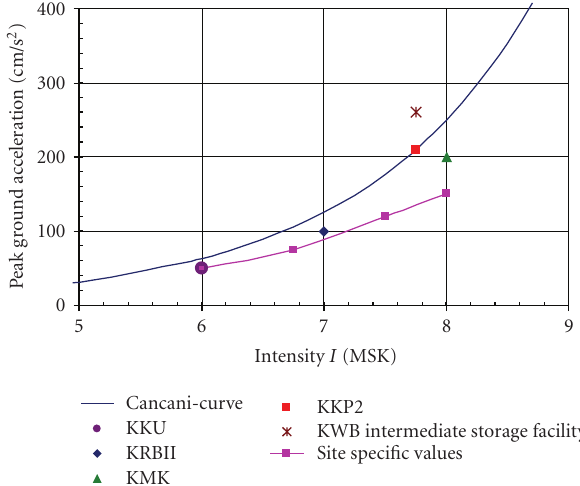
Figure 2: Classification of earthquake intensity to peak ground acceleration according to Cancani. Site specific spectra provide a higher level of accuracy and a possibility for